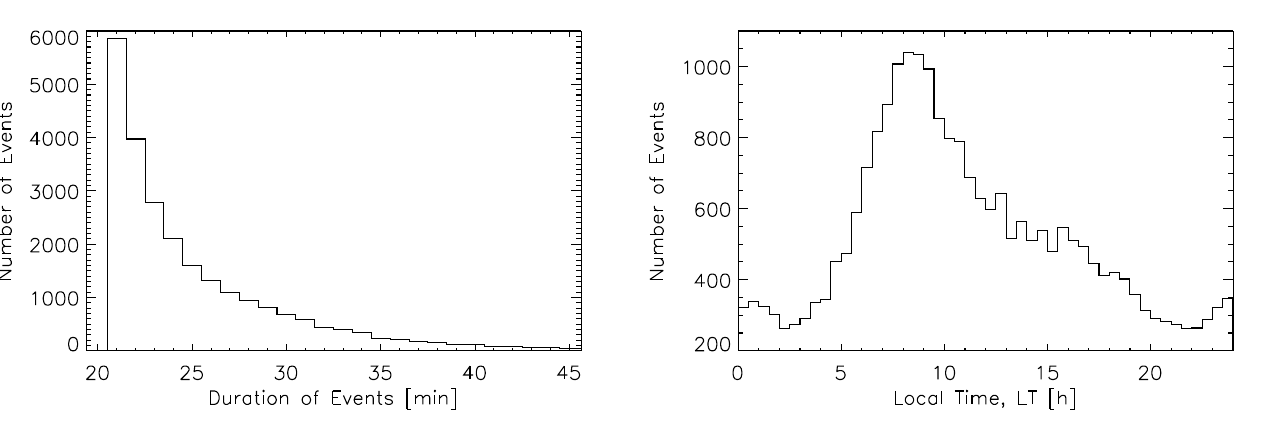
Fig. 2. Distribution of FLR event duration. Low duration events are clearly predominant. Binning used for the histogram: 1min.